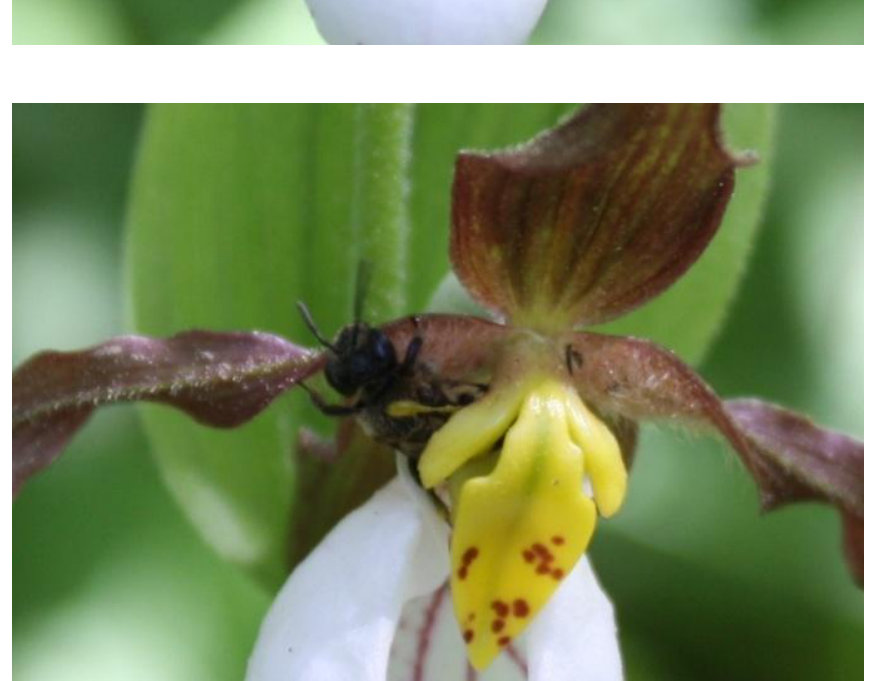
Figure 2. Unidentified bee inside inflated labellum. Note that the bee’s head is not visible as it is obscured by the staminode (Photograph by Nan Vance).